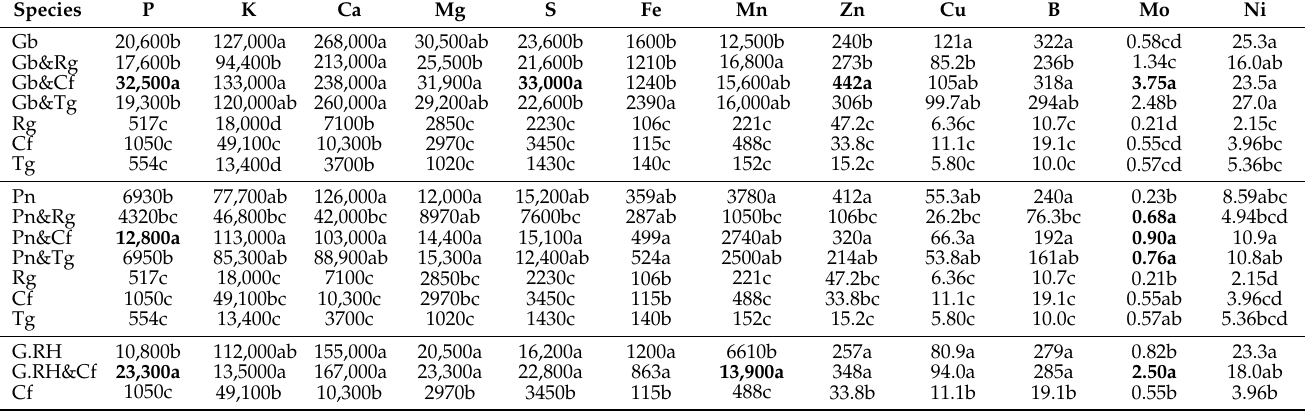
Table A4. The total uptake of each nutrient ( µ g) by all of the foliage contained in the pots (species combined), at final sampling, according to whether the six species were growing alone or with a companion species. (Gb: Grevillea barklyana , Pn; Protea neriifolia , G.RH; Grevillea Robin Hood, Cf, Cocksfoot; Rg, Ryegrass; Tg, Tussock grass). Different letters each indicate significant differences ( p < 0.05) within each block of treatments. Bold alphanumericals indicate significant differences to when the species was growing alone. Minimum detectable limits of Mo (0.02 mg kg − 1 ) were used for uptake calculations of this